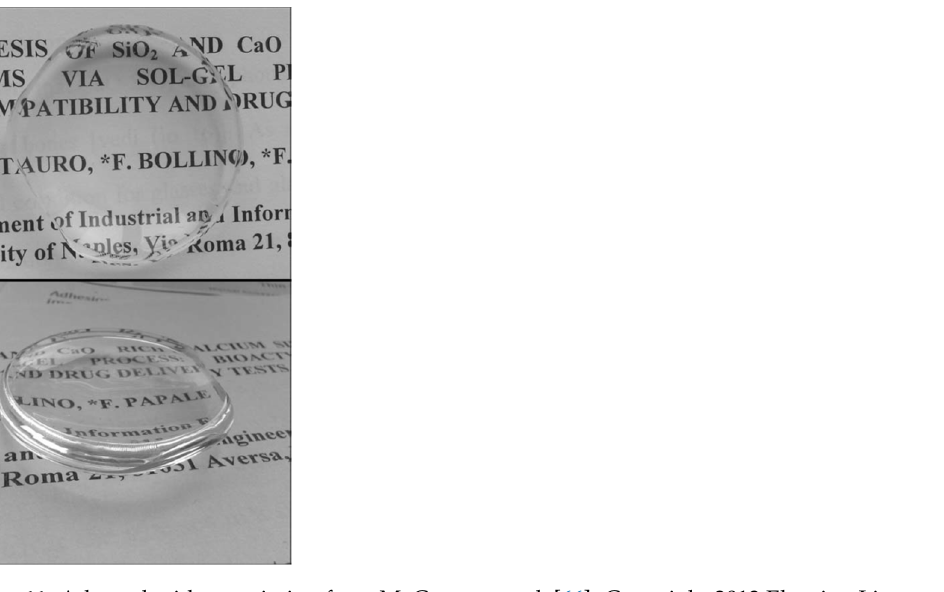
Figure 11. Adapted with permission from M. Catauro et al. [66]. Copyright 2013 Elsevier. License number 5318840223264. Ca/Si ampicillin doped bulks.